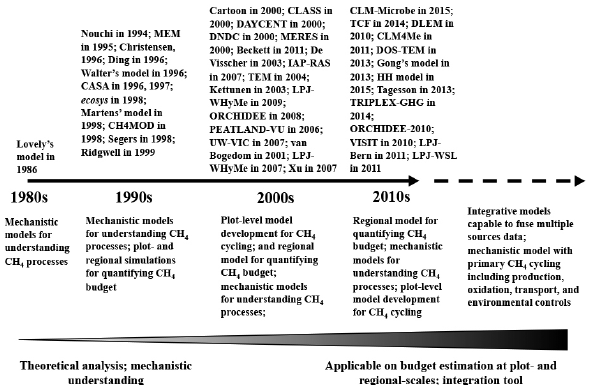
Figure 1. Published CH 4 models and modeling trends in terms of applicability and mechanistic representation of CH 4 cycling pro- cesses over recent decades; the envisioned CH 4 model